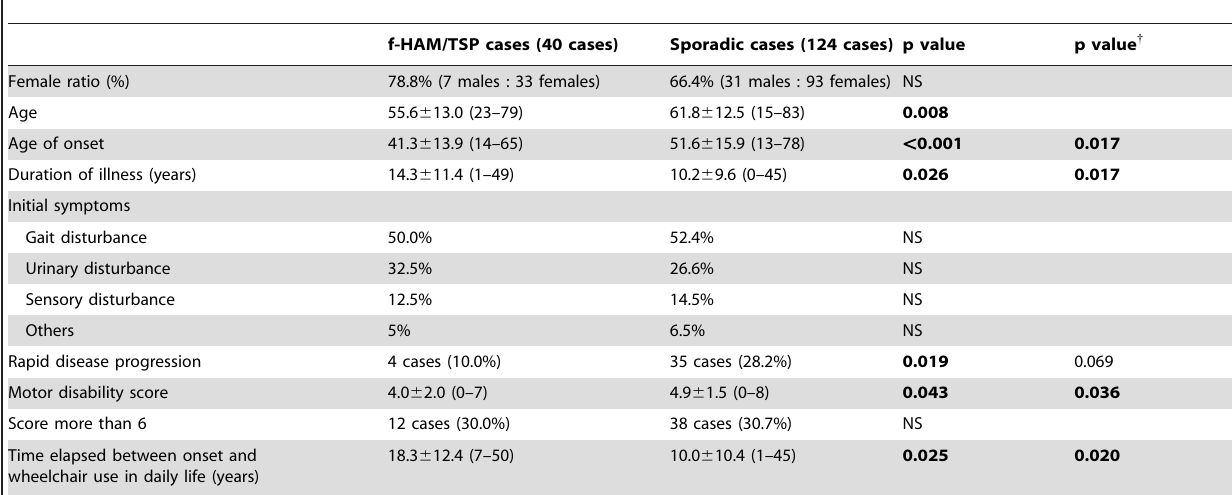
Table 1. Clinical features of f-HAM/TSP cases or sporadic cases of